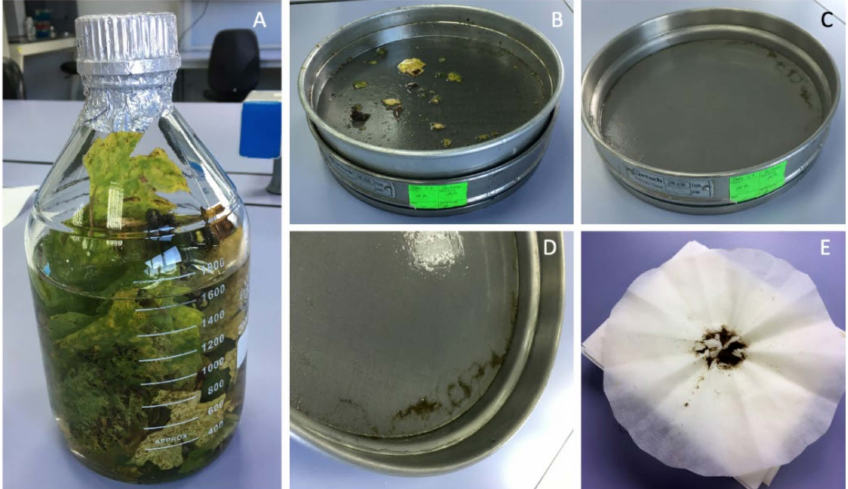
Figure 2. Chasmothecia obtaining process from ‘Godello’ variety grapevine leaves: ( A ) 100 g of chopped grapevine leaves in a 2 L bottle with 1.5 L of distilled water; ( B ) 0.2 mm sieve; ( C ) 0.1 mm sieve; ( D ) clean chasmothecia on the 0.2 mm sieve; ( E ) recovered chasmothecia by drying on a filter paper for subsequent